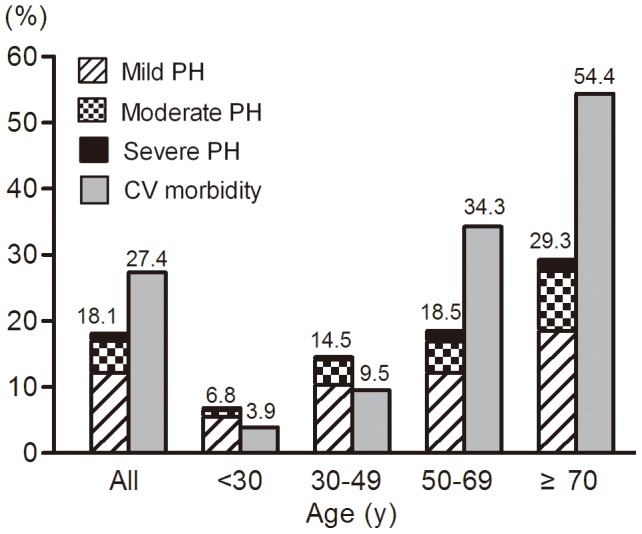
Prevalence of PH and CV morbidity stratified by different ages.Prevalence of both PH and CV morbidity showed an increasing trend with advanced ages.